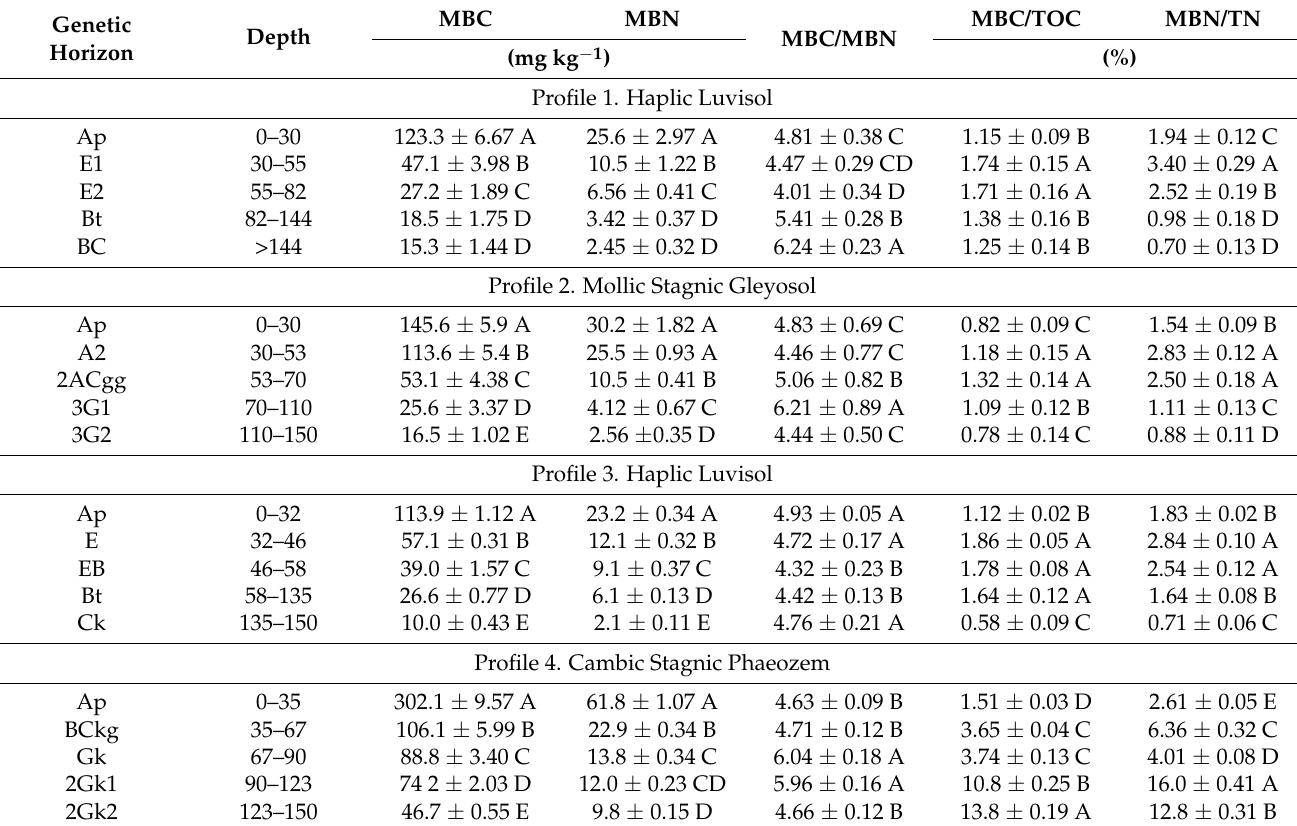
Table 3. Depth distribution of microbial biomass C and N; mean ( ± SE), n =